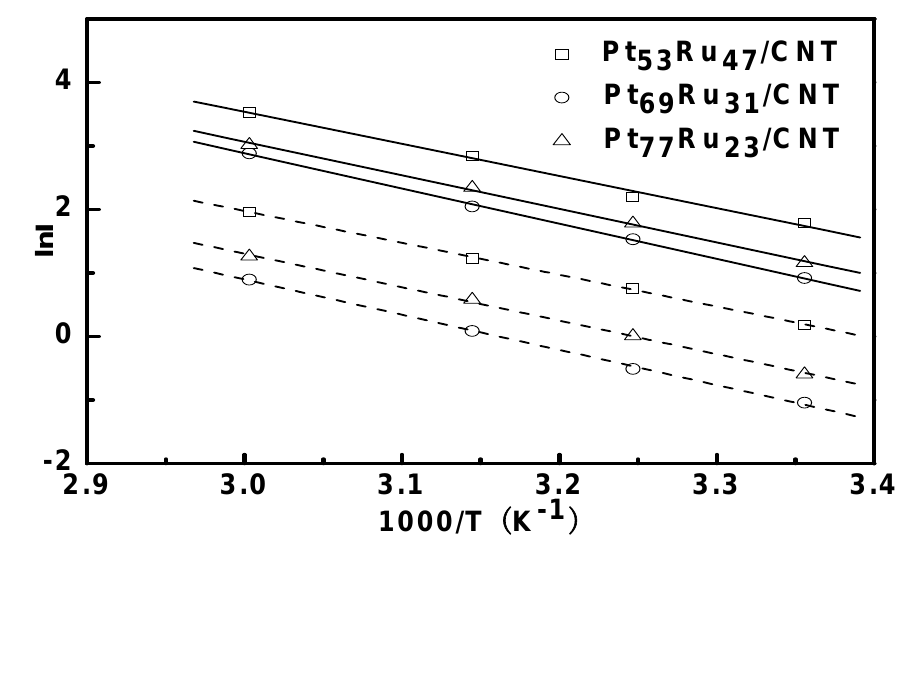
Figure 4. Arrhenius plots of the PtRu/CNT catalysts at different potentials, (—) 0.4 V and (—) 0.5